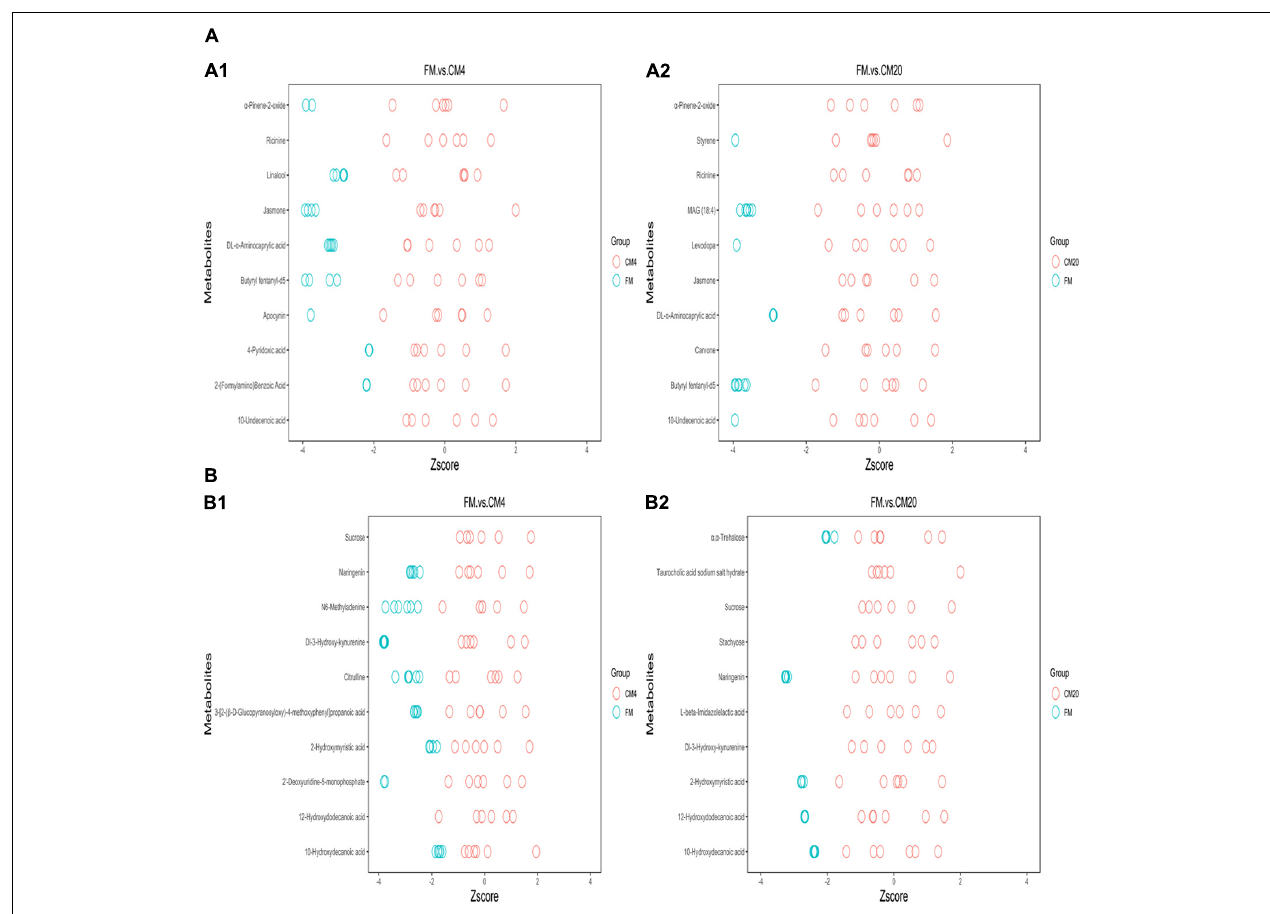
FIGURE 9 | The z -Score plot of the potential biomarkers for the comparison between FM, CM4, and CM20 groups in the positive (A1,A2) and negative (B1,B2) modes. Abbreviations are as defined in Figure 1 . n =